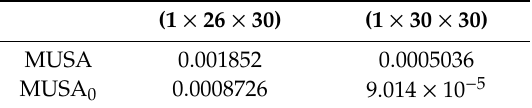
Table 3. BER vs. SNR for MUSA and MUSA 0 for SNR = 12 dB.